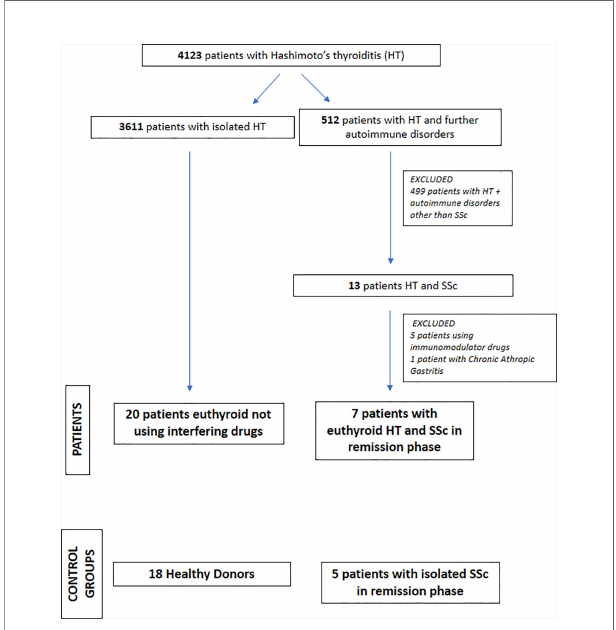
FIGURE 1 | Flow diagram of patients ’